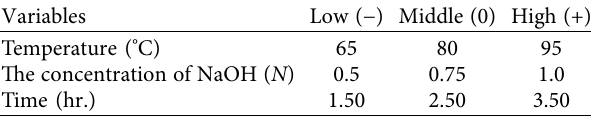
Table 1: Te Box-Behnken experimental design of KH